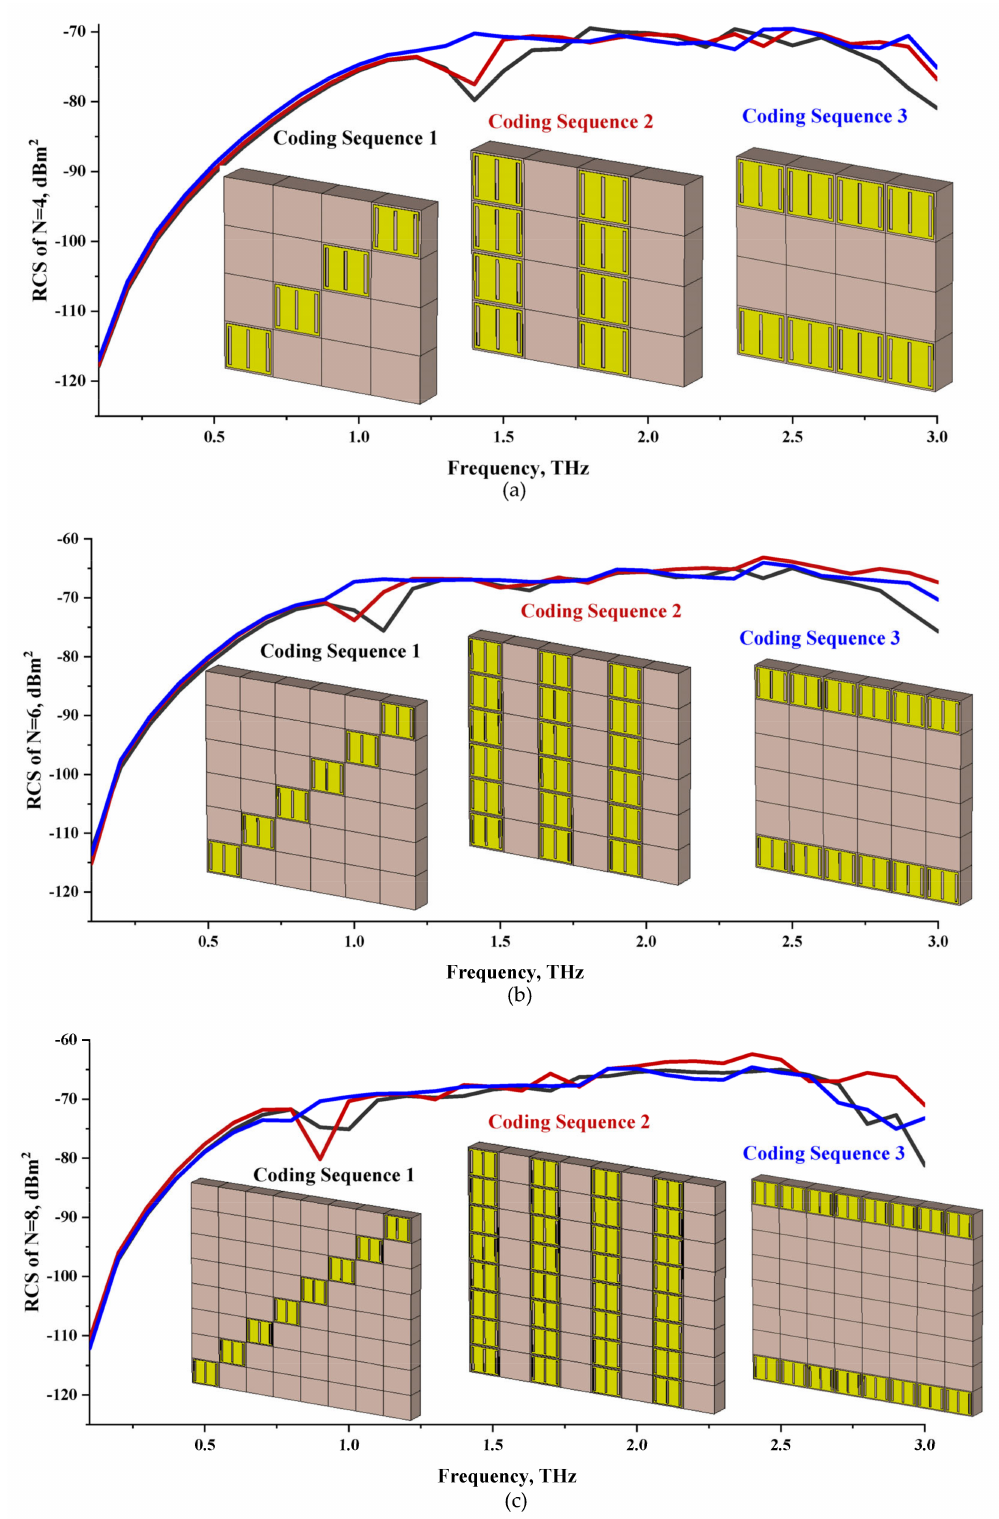
Figure 2. Monostatic RCS reduction of three different coding sequences in ( a ) N = 4; ( b ) N = 6; ( c ) N =